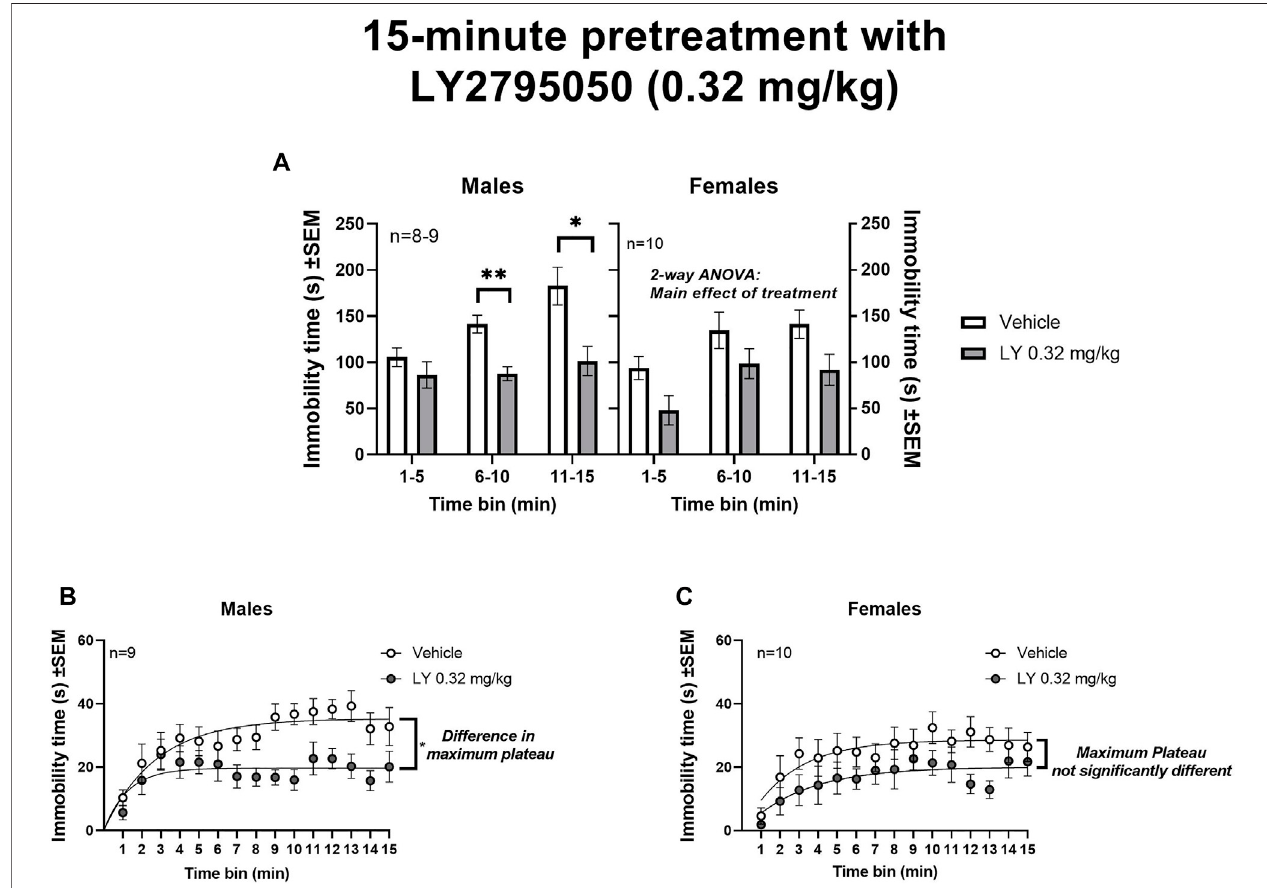
FIGURE 3 | Effect of 15-min pretreatment of LY2795050 (0.32 mg/kg, or vehicle) on immobility in the open space swim (15-min duration). (A) shows data in three consecutive 5-min bins, analyzed by mixed model 2-way ANOVA, in males and females (the data were also analyzed in a 3-Way ANOVA; see Results). (B,C) show data re-plotted as 1-min bins, in males and females respectively. The regression lines in (B) (males) show exponential plateau growth curves; the fi tted maximum plateau for immobilityissigni fi cantlylowerforLY2795050versusvehicle.In (C) (females),the fi ttedmaximumplateauisnotsigni fi cantlydifferentforLY2795050versusvehicle.